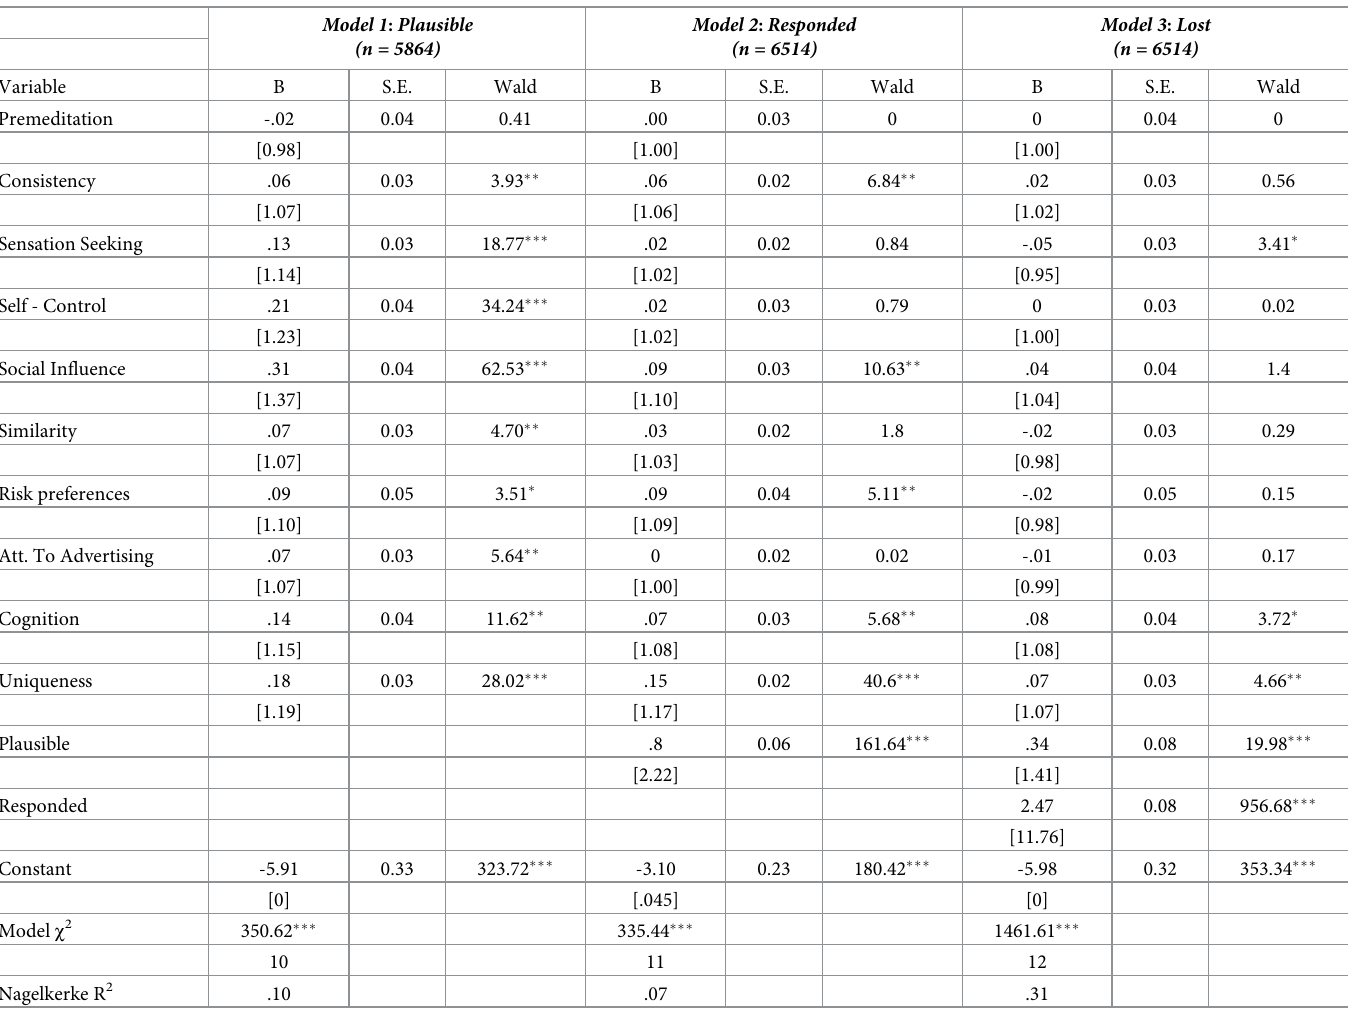
Table 6. Logistic regression models for StP-II salience across the stages of universal scam